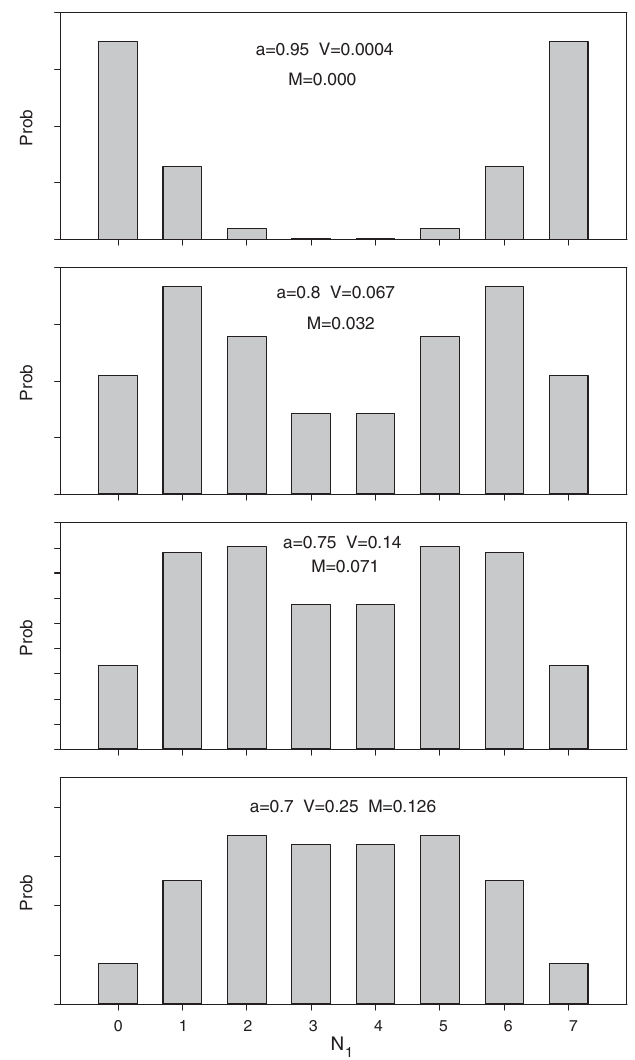
FIG. 7. Probability distribution of the response vectors of symmetric probability vectors. V is the overlap between the two vectors in the model. M is the misassignment rate in a simulated clustering